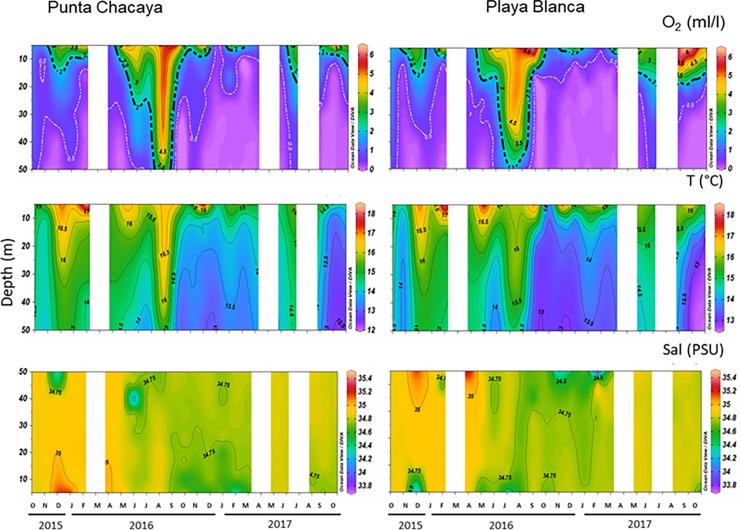
Oceanographic parameters.Time series of temperature of dissolved oxygen, temperature and salinity at during the study period and sites. Blank spaces indicate months with no sampling.